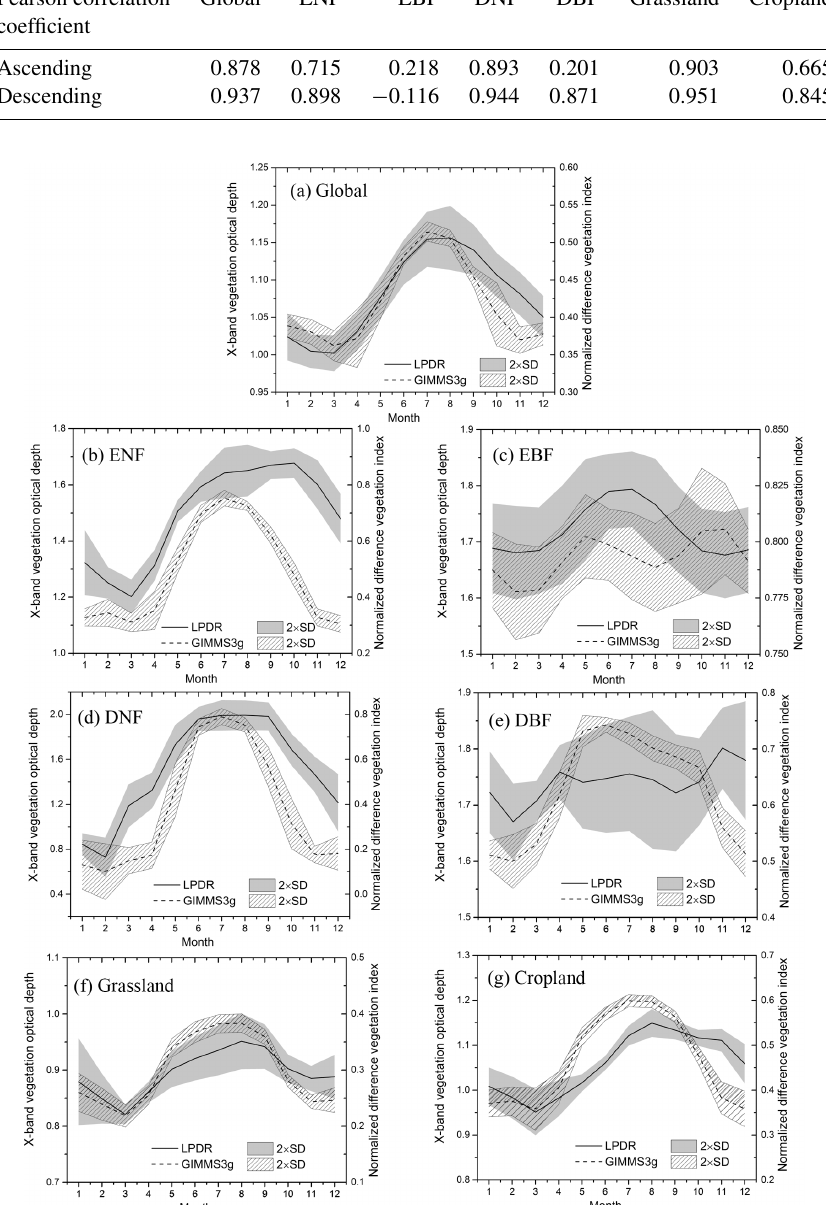
Figure 8. Monthly means and variations (2 × SD) of LPDR X-band vegetation optical depth (VOD) and GIMMS3g NDVI for all global vegetation (a) and selected land cover types, including ENF (b) , EBF (c) , DNF (d) , DBF (e) , grassland (f) , and cropland (g) areas over